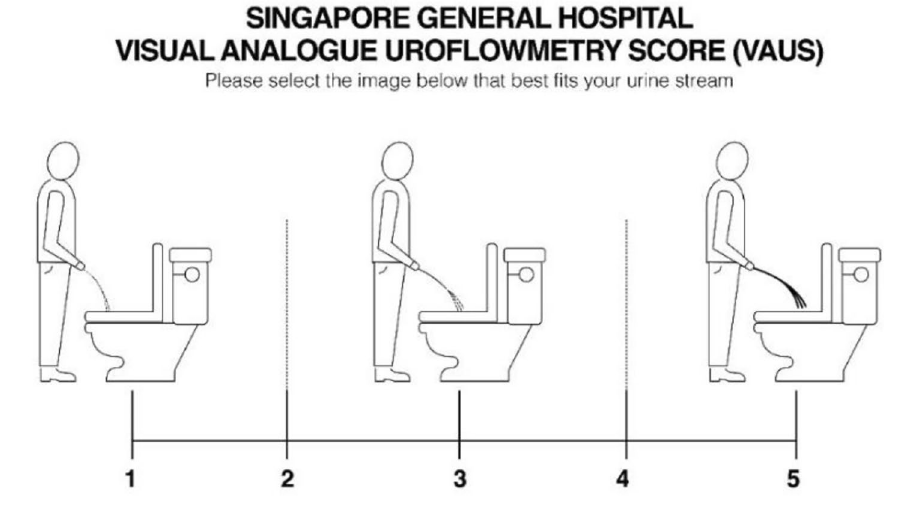
Fig. 1 Visual analogue uroflowmetry score. A novel Likert score with 1 being slowest stream and least volume, and 5 being fastest stream and highest volume Raj Tiwari, Ng MY, Neo SH, R Mangat, H Ho. Prospective validation of a novel visual analogue uroflowmetry score (VAUS) in 1000 men with lower urinary tract symptoms (LUTS). World Journal of Urology 2020; 38(5);1267–1273 doi: